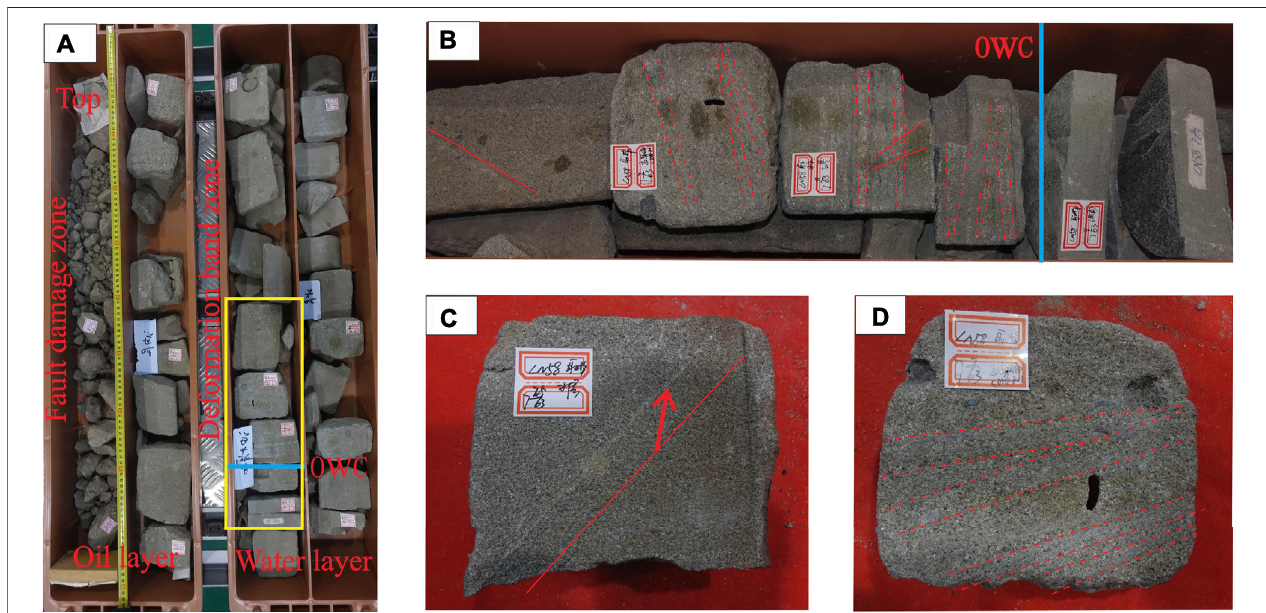
FIGURE 4 | (A) Core samples collected from the T2 oil group, LN58 well (depth: 4,369 – 4,373 m). (B) Abundant deformation bands near the fault zone; its density increases while approaching the fault zone. The single band is indicated using a red line, and the cluster band boundary is indicated using a red dotted line. (C) Characteristic of the single band. (D) Characteristic of the cluster